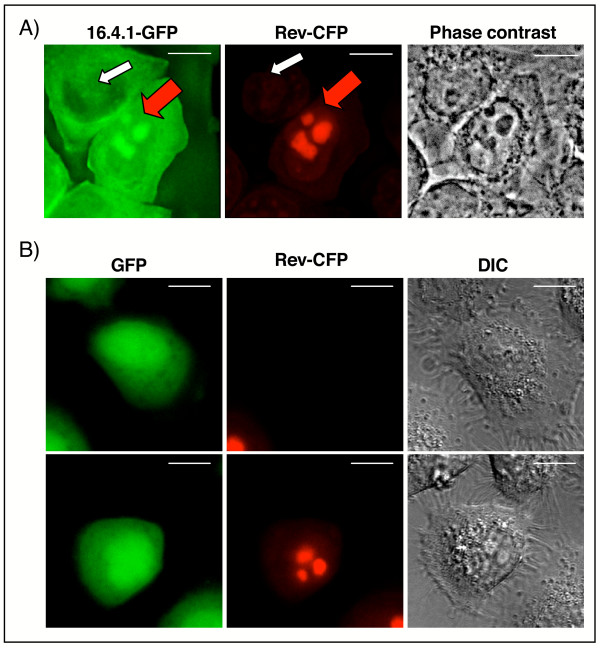
Nucleolar colocalization of 16.4.1-GFP and Rev-CFP. HeLa 16.4.1-GFP cells and control HeLa GFP cells were transiently transfected with a Rev-CFP expression plasmid. Nuclei were counterstained with Hoechst 33342. 3D-Maximum image projections of Z-stacks were deconvolved and processed by multichannel unmixing, applying identical parameters to all images (see Material and Methods). Left images represent the GFP-channel (green), middle images the CFP-channel (pseudocolored red) and right images either an interference contrast photo (A) or a single z-slice of a phase contrast image (B). (A) Exemplary images of over 25 analyzed cells demonstrating nucleolar colocalization of 16.4.1-GFP and Rev-CFP. The left image shows HeLa-16.4.1-GFP cells either without Rev-CFP (white arrow), or with concurrent Rev-CFP expression (red arrow). The nucleolar 16.4.1-GFP signal is only visible in cells coexpressing Rev-CFP. Cells with extremely high expression levels of Rev-CFP were excluded from analysis. Scale bars: 10 μm. (B) Controls for separation of GFP and CFP and signals by multichannel unmixing. Images of HeLa cells stably expressing GFP (HeLa-GFP) either alone or together with Rev-CFP are shown in the upper and lower panels, respectively. The intracellular distribution of the GFP signal is not influenced by coexpression of Rev-CFP. Conversely, a nuclear/nucleolar CFP signal is detected only in HeLa-GFP cells coexpressing Rev-CFP. These results confirm that multichannel unmixing eliminates spectral crosstalk between CFP and GFP channels. Scale bars: 10 μm.